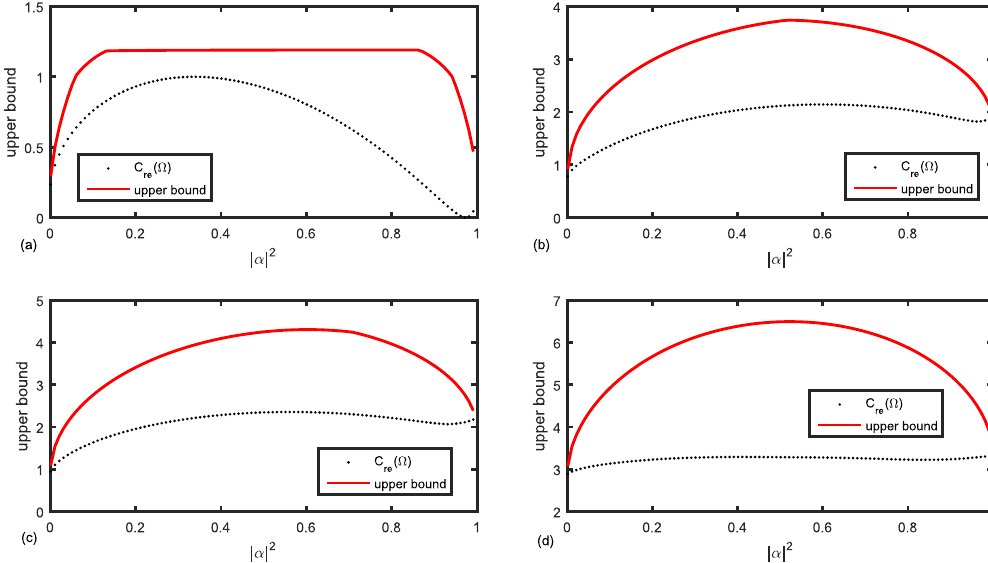
Figure 1. The upper bounds on coherence of the superpositions for dimension = 2, 5, 7, 15, with | Φ 〉 and | Ψ